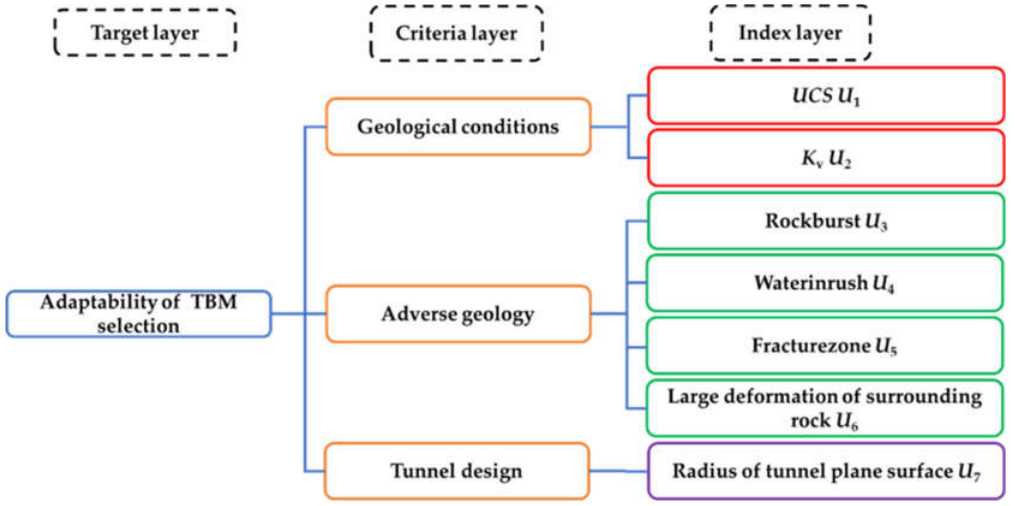
Figure 2. Evaluation index system of TBM selection decision-making.